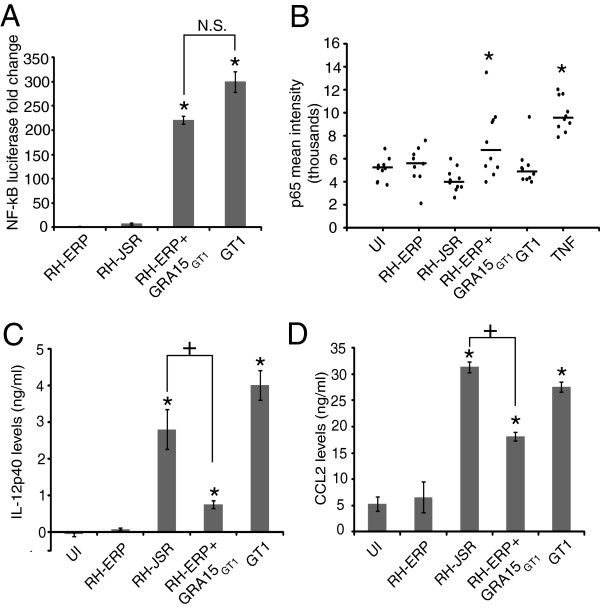
Type I strains differentially activate NF-kB nuclear translocation, and is dependent on GRA15. (A) HEK293T NF-kB reporter cells were infected with RH-ERP, RH-JSR, RH+GRA15GT1 and GT1. For each strain, the luciferase reading after 24 hours infection was taken. The graph shows averages from three independent experiments, with levels representing fold change of NF-kB luciferase readings normalized to uninfected, unstimulated control cells, and the error bars represent the standard error. Mean + SEM, of three experiments, * p-value < 0.01, N.S. not significant, Student’s t-test. (B) HFFs were infected for 24 h with RH-ERP, RH-JSR, GT1 and RH+GRA15GT1 transgenic, uninfected cells were stimulated with TNF-alpha for 1 h (TNF), or left unstimulated and uninfected (UI). Cells were fixed, probed with p65 antibody and mean nuclear staining was quantified, the error bars represent the standard deviation, * p-value < 0.05, Student’s t-test. Quantification shown is representative of three independent experiments. (C) IL12-p40 and (D) CCL2 levels were measured in supernatants from C57BL/6 bone marrow derived macrophages infected for 24 hours with RH-ERP, RH-JSR, RH+GRA15GT1 transgenic and GT1. The graphs shown are representative of three independent experiments for IL-12p40 and two independent experiments for CCL2, and the error bars represent the standard deviation, * p-value < 0.01, Student’s t-test between strain and RH-ERP infected BMMs, + p-value < 0.01, Student’s t-test between the two conditions indicated.